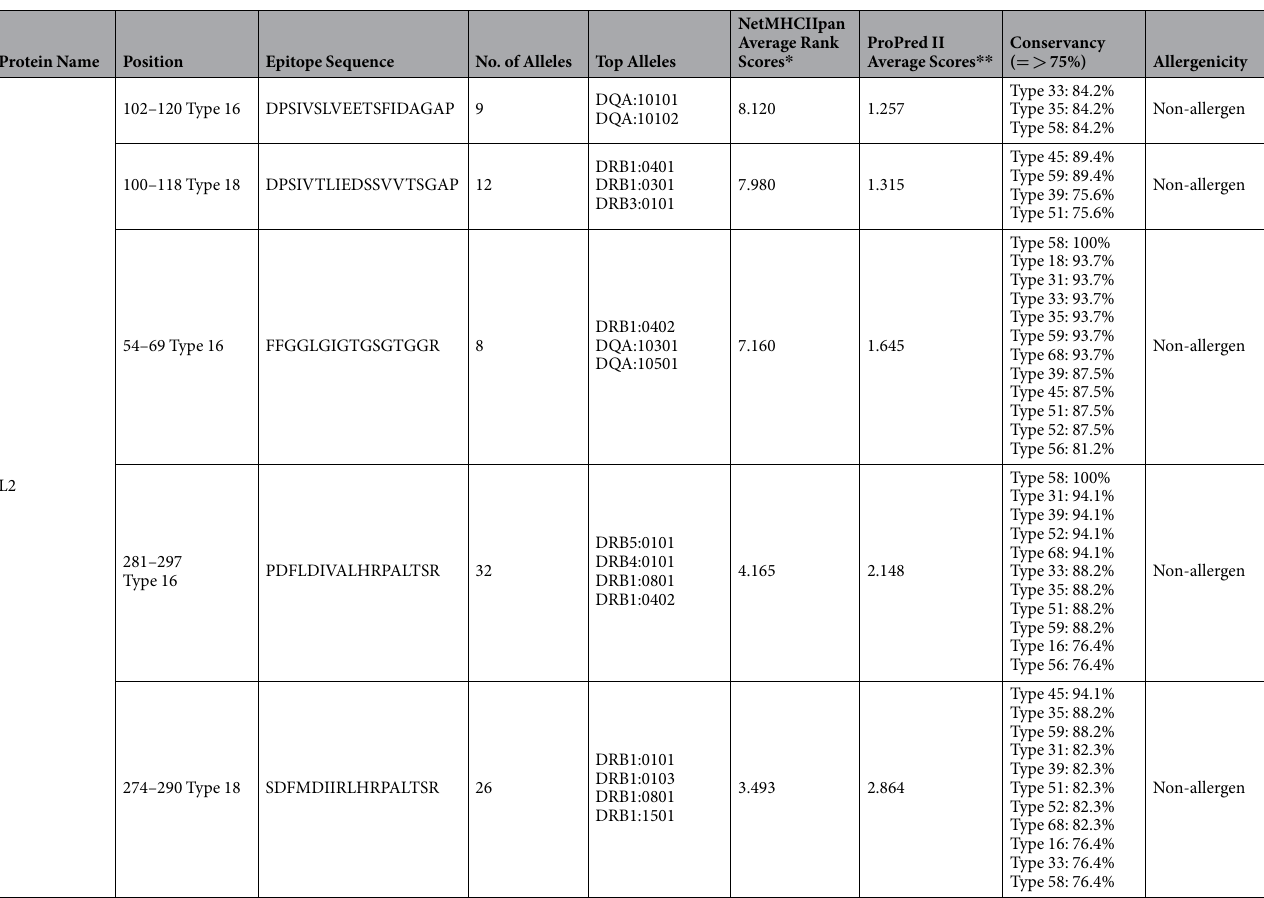
Table 7. The selected helper T Cell epitopes of HPV L2 protein, based on binding affinity. * lower rates show better binding affinity, ** Higher rates show better binding